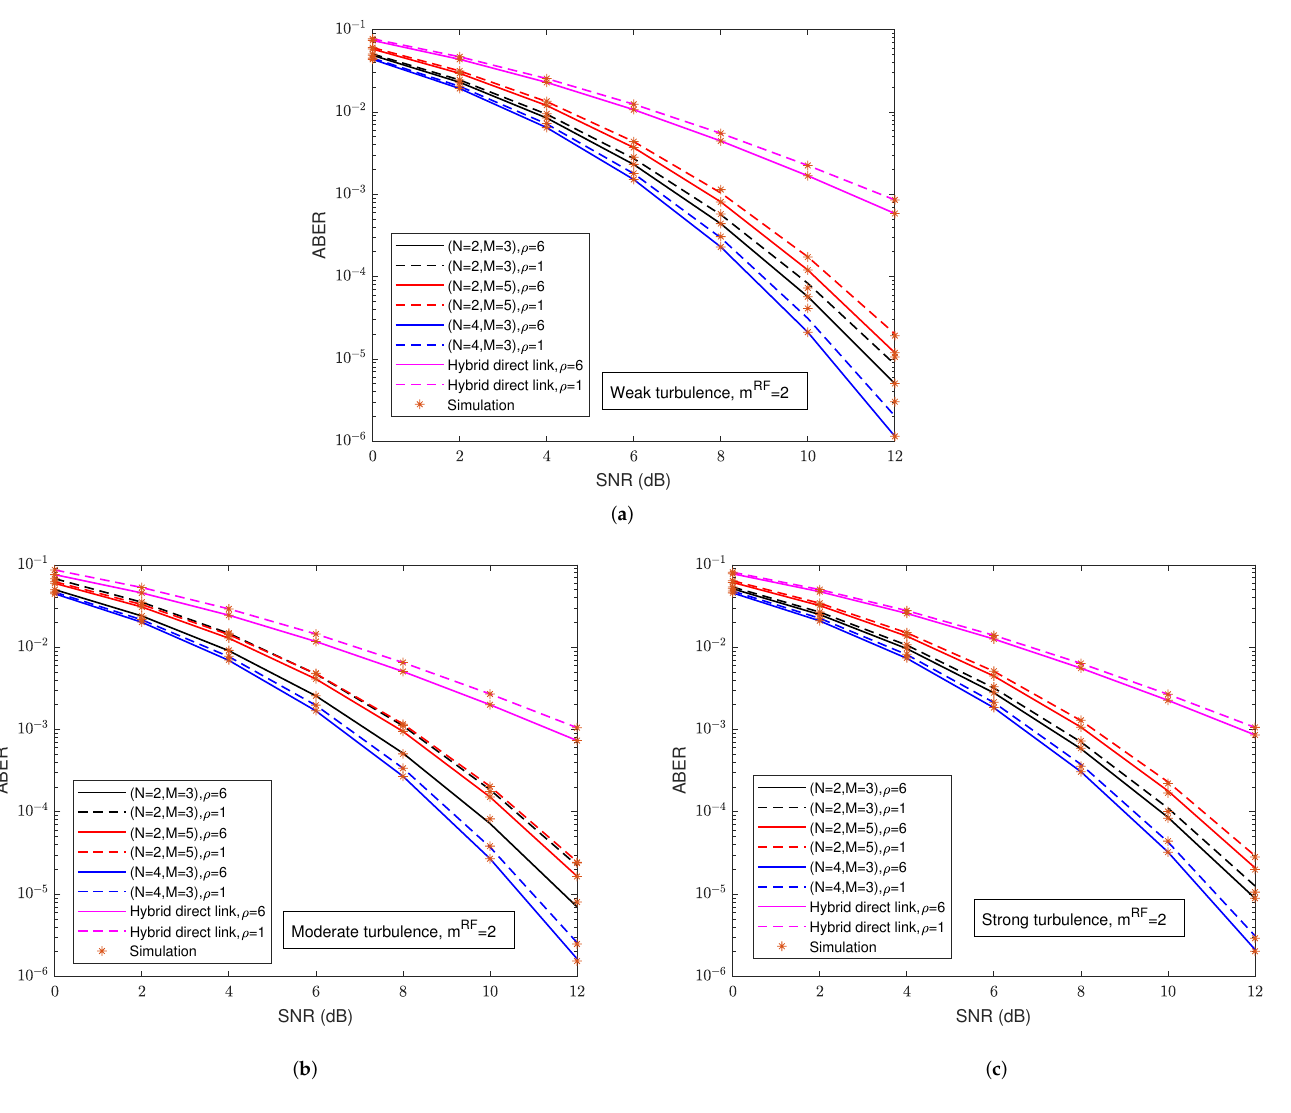
Figure 5. The relationship between ABER and SNR of the multi-hop parallel hybrid FSO/RF system and the hybrid FSO/RF direct link under different turbulence intensities, different relay-assisted structures, and different pointing errors. ( a ) weak turbulence. ( b ) Moderate turbulence. ( c ) Strong